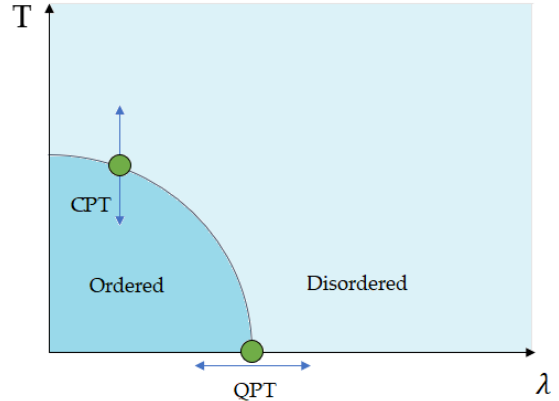
Figure 1. Schematic phase diagram for a system undergoing a zero-temperature quantum phase transition (QPT) driven by the parameter λ , and a finite-temperature classical phase transition (CPT) driven by the temperature.